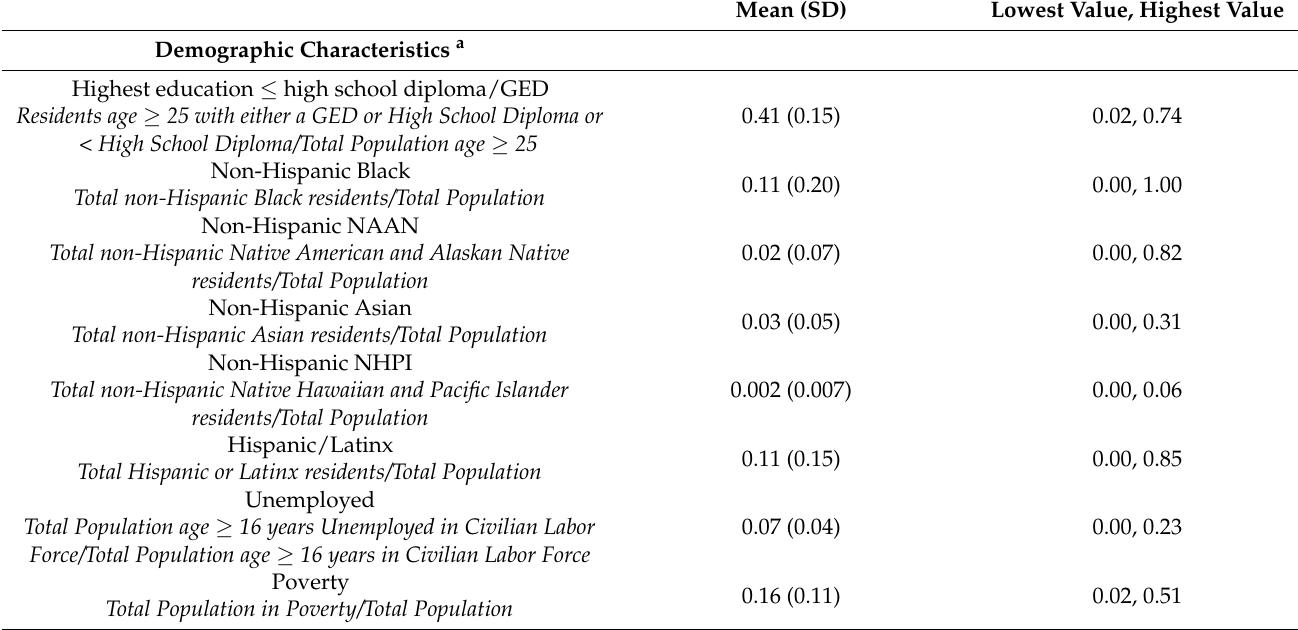
Table 1. Descriptives of Proportion of Census Tract Populations in Census Tracts of Surveyed Libraries based on the 2013–2017 American Community Survey 5-year estimates as provided by the National Historical Geographic Information System.